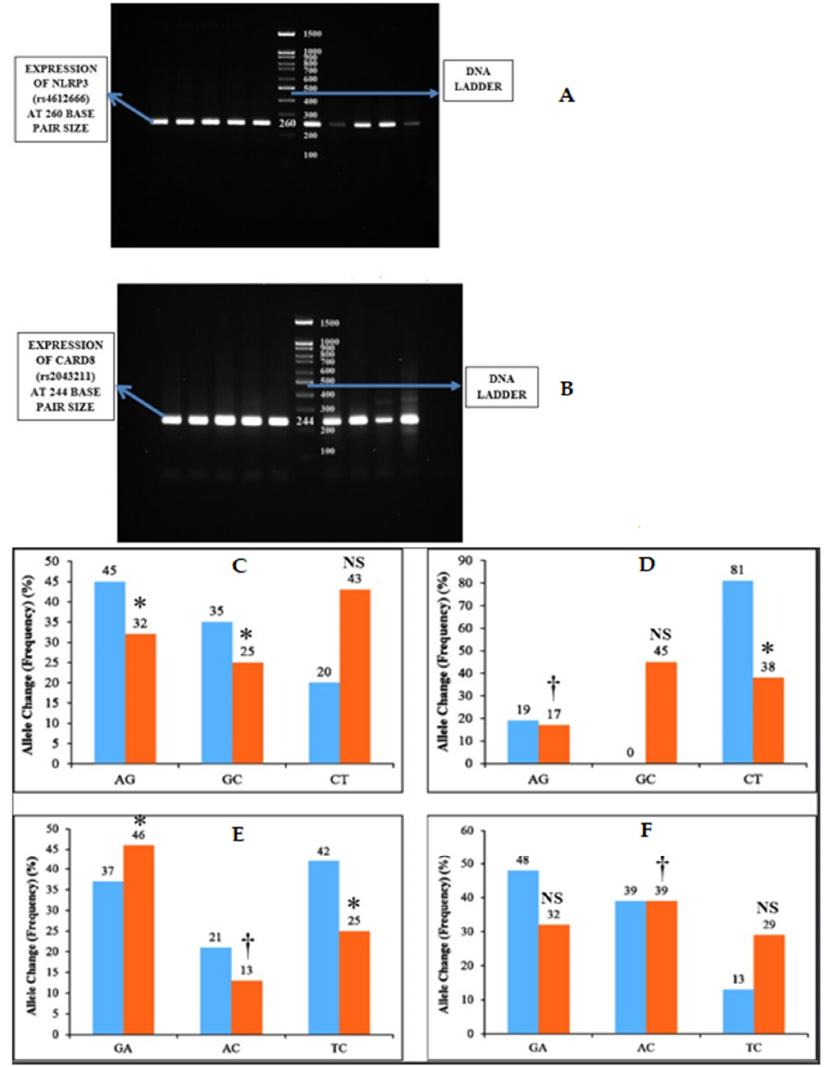
Figure 2. Inflammasome expression and allele change among the two groups. ( A–B ) NLRP3 (rs4612666) was expressed as PCR bands at 260 bp size and CARD8 (rs2043211) as PCR bands at 244 bp size. ( C ) represents the Allele change of NLRP3 (rs4612666) in subgingival plaque and ( D ) represents the allele change of NLRP3 (rs4612666) in blood samples among the two groups. ( E ) represents allele change of CARD8 (rs2043211) in subgingival plaque and ( F ) represents allele change of CARD8 (rs2043211) in blood samples among the two groups. The horizontal lane in (A) represents the expression of NLRP3 and (B) represents CARD8 polymorphism. * p < 0.05 is considered to be statistically signi fi cant, † p < 0.01 is con- sidered to be highly statistically significant, NS—Non-significant.